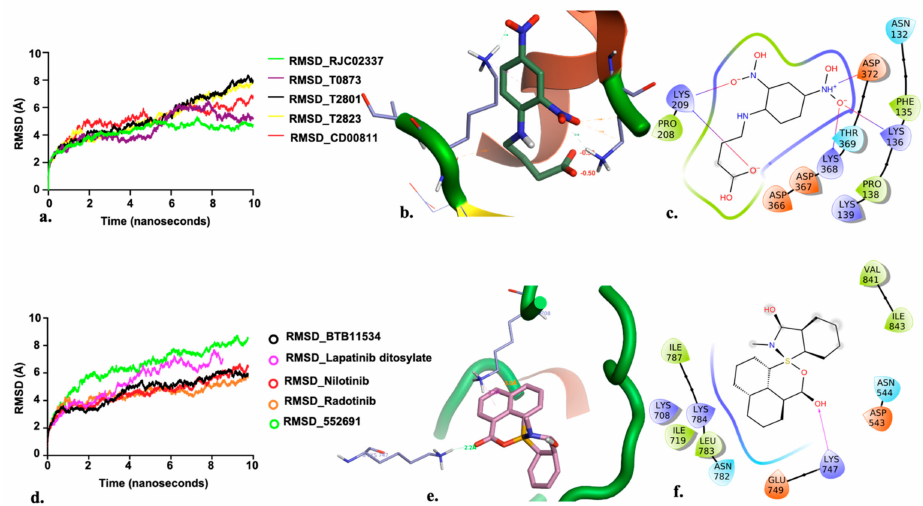
Figure 5. ( a ) RMSD for the top five PfDegP-complexes from the allosteric site and it was quite evident that the two complexes RJC02337 and T0873 attained stability. The complex PfDegP-RJC02337 (green) was quite stable for the whole simulation period exhibiting the least fluctuations, whereas complex PfDegP-T0873 (purple) tends to attain its stability after a simulation period of ~8 nanoseconds. However, the complexes PfDegP-T2823 (black), PfDegP-T2801 (yellow) and CD00811 (red) exhibited a continuous increase in their RMSD, indicating their unstable interaction with the protein. ( b ) Least binding energy pose of Maybridge_RJC02337 docked with PfDegP ( c ) Ligand interaction diagram of Maybridge_RJC02337 showing the interacting residues with PfDegP ( d ) The RMSD for the top five PfDegP- complexes and it was quite evident that the DegP complex with BTB11534, Lapatinib ditosylate, Radotinib, 552691 attained stability while the complex with Nilotinib exhibited the in- creased RMSD ( e ) Least binding energy pose of Maybridge_BTB11534 docked with PfDegP ( f ) Ligand interaction diagram of Maybridge_BTB11534 showing the interacting residues with